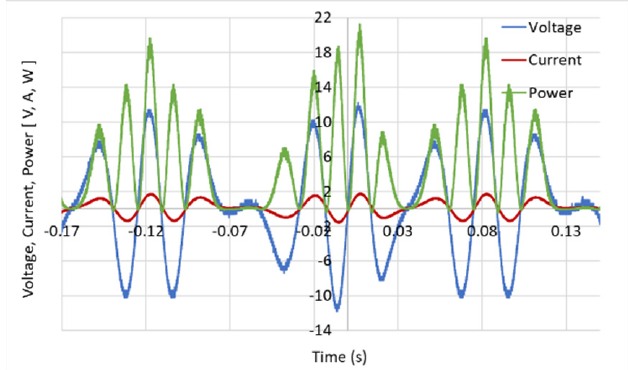
Figure 27. Voltage, current, and electric power of one phase at 300 rpm with peak of ~ 0.5 m/s.